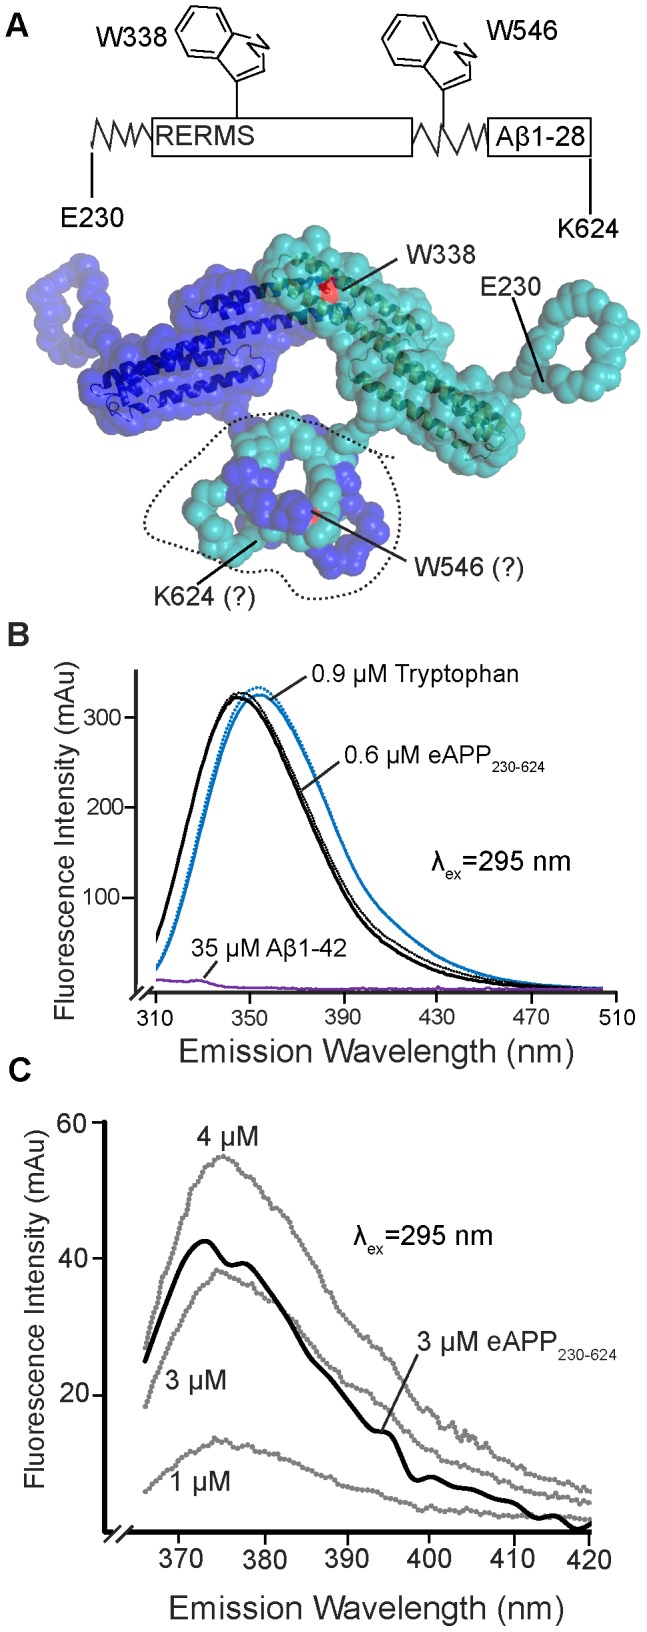
The intrinsic fluorescence of eAPP230–624.A) Model of the eAPP230–624 dimer derived from the SAXS model of eAPP19–624
[18] illustrating the location of the tryptophans in eAPP230–624 with respect to the dimerization interfaces. One monomer is shown in cyan and the second monomer is shown in blue. The surface corresponding to W338 is colored red. The corresponding residue in the blue monomer is on the back face, hidden in this view. The location of W546 and K624 cannot be precisely determined because of the low resolution of the model (20 Å). The two residues are located within the volume encircled by the dashed line. B) Emission peak of 0.64 µM eAPP230–624 in PBS (black solid) and PBS containing 3.3% DMSO (black dotted) obtained with an excitation wavelength (λex) of 295 nm using a Shimadzu RF-530PC spectrophotometer with a 4 ml quartz cuvette. For comparison, the spectra of 9 µM tryptophan in PBS (blue solid) and PBS-containing 3.3% DMSO (blue dotted) and 12 µM Aβ1-42 13-kDa oligomers in PBS (purple) are shown. C) Emission peak of 3 µM eAPP230–624 in PBS obtained with an excitation wavelength (λex) of 295 nm using a Spectramax XPS spectrophotometer (black). For reference, the emission spectra of 1–4 µM of tryptophan are also shown (grey). The peak shown is created by the design of the instrument, which displays reduced sensitivity as the wavelength approaches 360 nm.